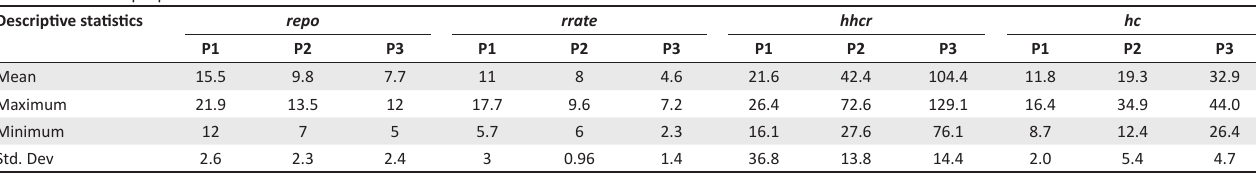
TABLE 3-A1: Data properties.